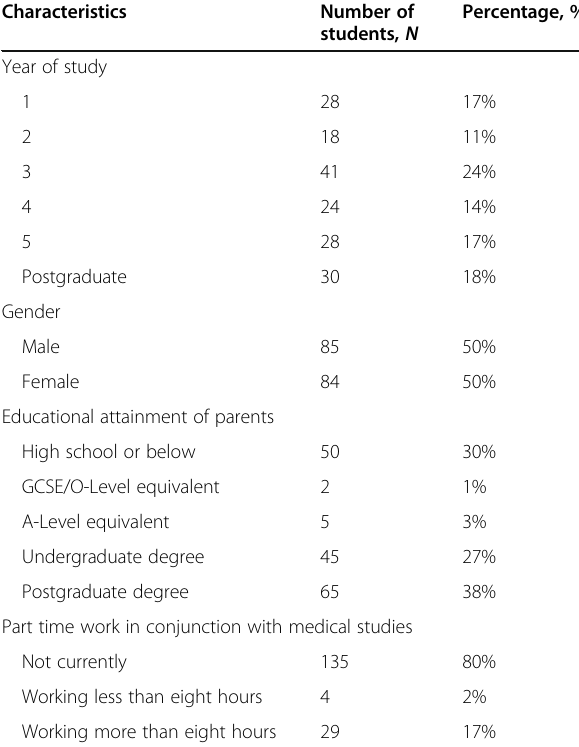
Table 1 The sociodemographic characteristics of the Nepalese